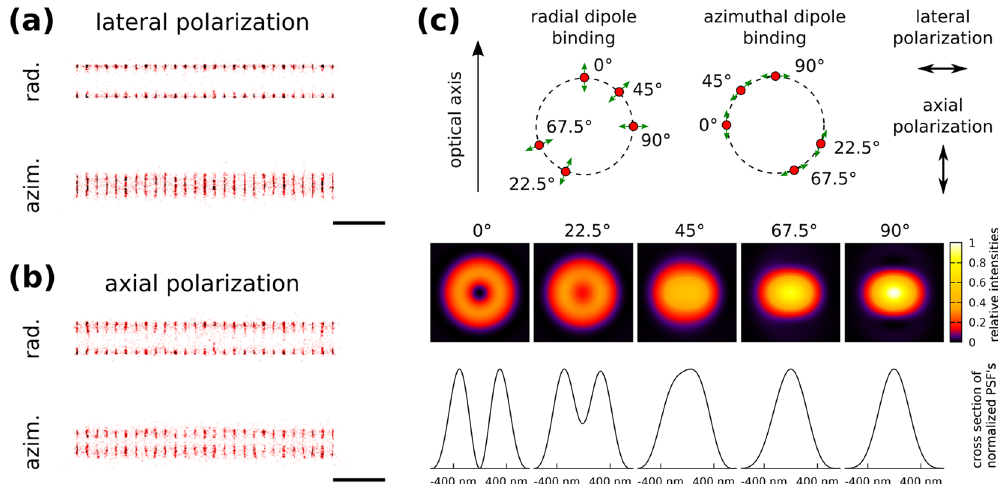
Figure 2. Polarization sensitive SMLM images of actin rings labelled by rigid fluorescent dyes with dipoles of radial and azimuthal orientations. Depending on the polarization of the excitation beam ( a , b ) dyes with specific orientations located at different regions on the rings can be excited. The acceptance of the localizations strongly depends on the shape of the PSF ( c ) determined by the relative position of the dye molecule to the optical axis. Scale bar is 1 micron.